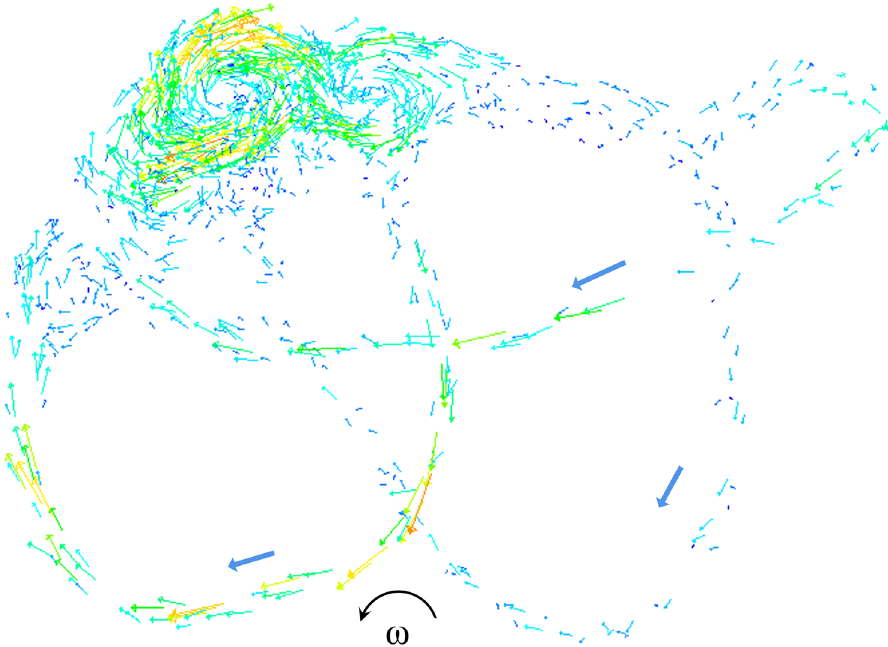
Figure 3. Schematic drawing of the relative movement of endolymph in SCCs at time = 0.1 s. SCCs are rotated with anticlockwise